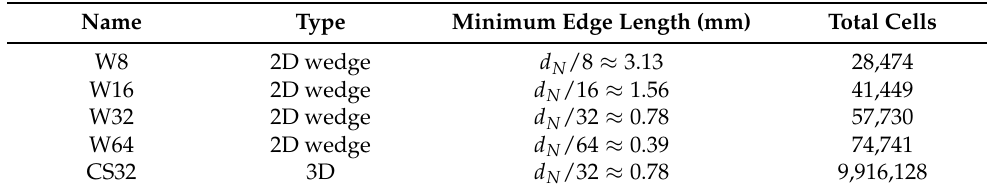
Table 1. Impinging